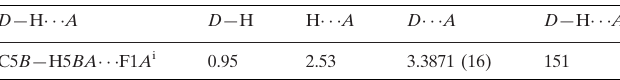
Hydrogen-bond geometry (A˚ , (cid:2)